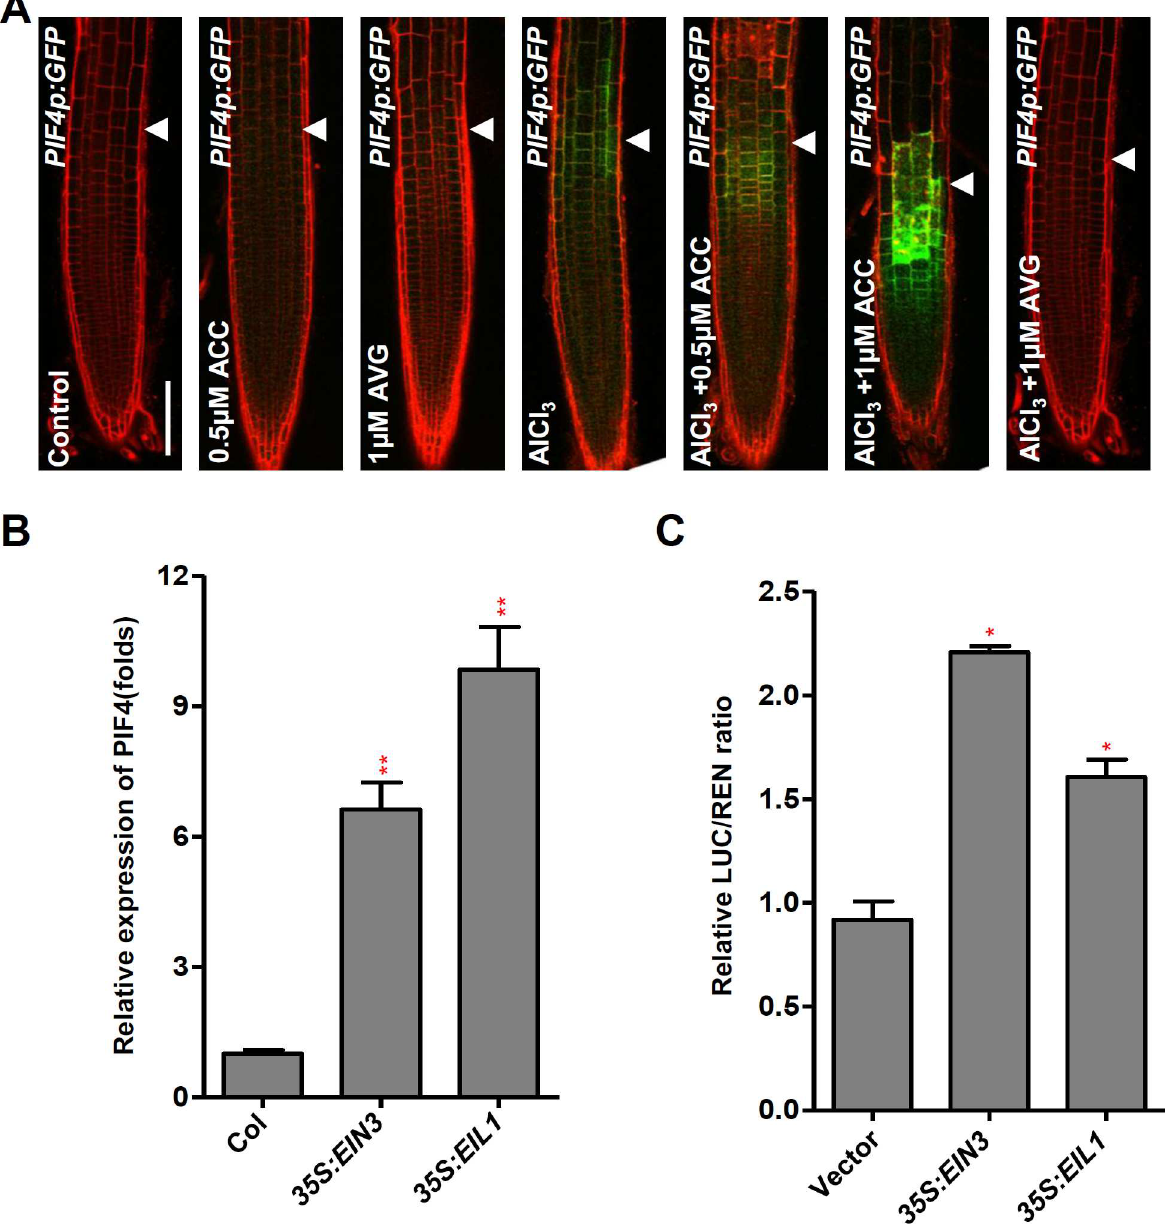
Fig 11. The Al-induced local expression of PIF4 acts downstream of ethylene signaling. (A) The expression of PIF4p : GFP transgenes in the root apex epidermisin presence of Al and either ACC or/and AVG. Four-day old transgenic PIF4p : GFP seedlings were pre-treated with 1 μ M AVG or 0.5 μ M ACC for 1 day, then the seedlingswere treated with 1 μ M AVG, 0.5 or 1 μ M ACC in the presence or not of 25 μ M AlCl 3 for 2 hours. Cell boundaries appear red followingpropidiumiodide staining. The TZ is marked by white arrowheads.Scale bar: 100 μ m. (B) Relative transcript abundanceof PIF4 in 7-d-old Col, 35S : EIN3 and 35S : EIL1 seedlingsroots. (C) Transient dual-luciferase assay shows that EIN3 or EIL1 transactivates the promoter of PIF4 in Arabidopsis protoplasts. In (B) and (C) , data represent the means of three biologicalreplicates. Error bars represent Student’s t test confidence intervals (n = 3). Statistical significant difference indicated by asterisks (Fisher’s exact test, * P < 0.05, ** P < 0.01).